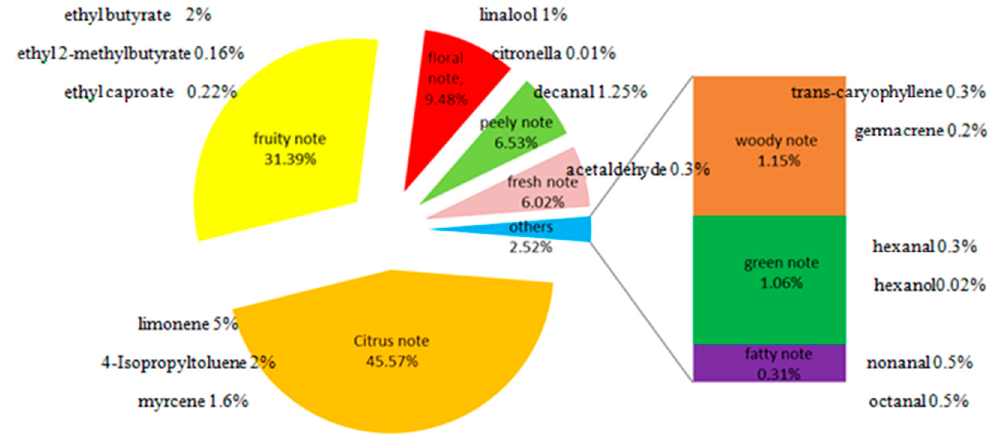
Figure 3. 8 base modules of sweet orange flavor (the remaining proportion of each note comprises edible ethanol solvent).